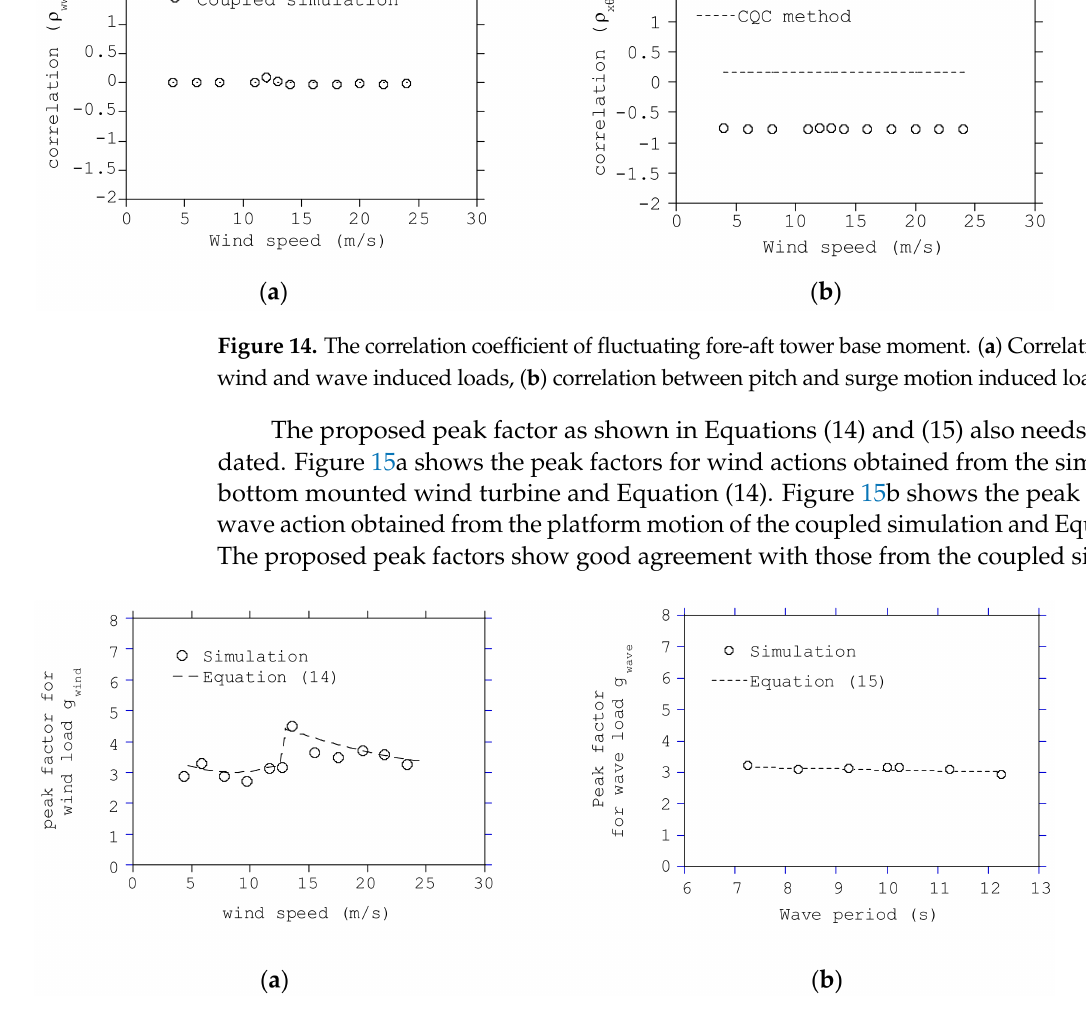
Figure 15. Comparison of the peak factors of fore-aft tower base moment: ( a ) wind load, ( b ) wave